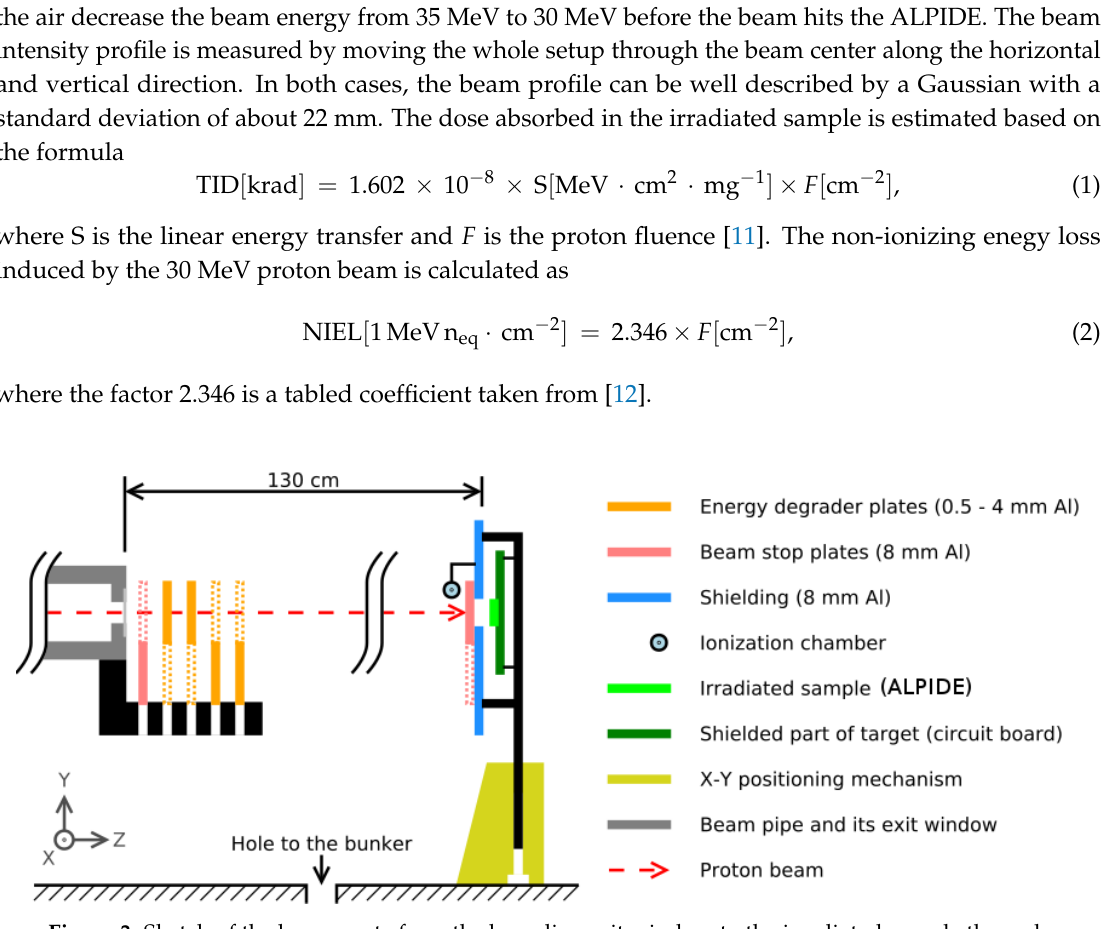
Figure 3. Sketch of the beam route from the beamline exit window to the irradiated sample through energy degrader plates, taken from